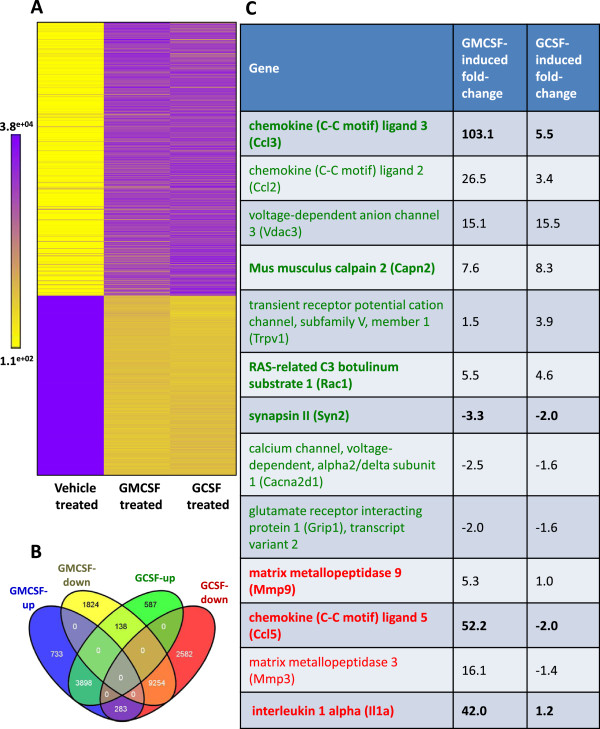
GMCSF- or GCSF- mediated gene pool in the peripheral sensory neurons. (A) Heat map representation of significantly-regulated transcripts showing more than two-fold change (two-tailed t-test assuming equal variance, P with Benjamini and Hochberg False Discovery Rate correction <0.05) following chronic exposure to GMCSF or GCSF in sensory neurons of the DRG. The color scale represents quantile normalized hybridization intensities for each gene. (B) Venn diagram representing the number of genes commonly or differentially regulated by GMCSF and GCSF exposure in DRG neurons. (C) Selected pain-related genes that were significantly regulated (two-tailed t-test assuming equal variance, P with Benjamini and Hochberg False Discovery Rate correction <0.05). Genes commonly (green text) or differently (red text) regulated by GMCSF and GCSF stimulation in sensory neurons are shown. Gene regulation confirmed by qRT-PCR analysis is highlighted in bold text.